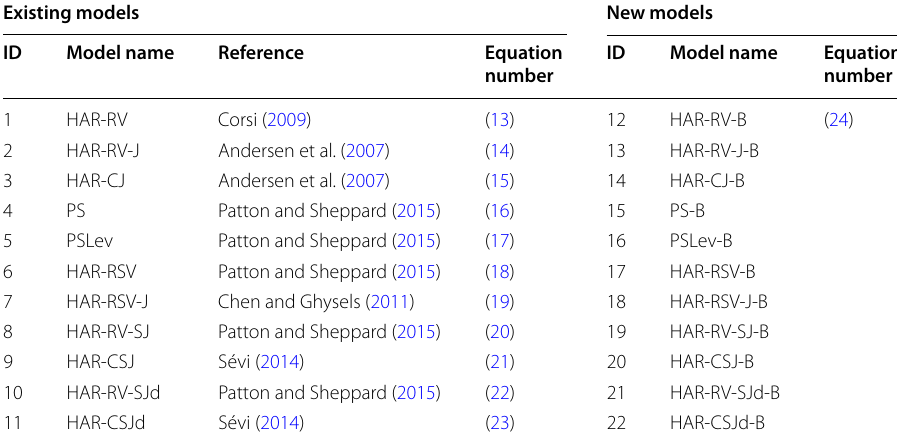
Table 1 Models specifications Existing